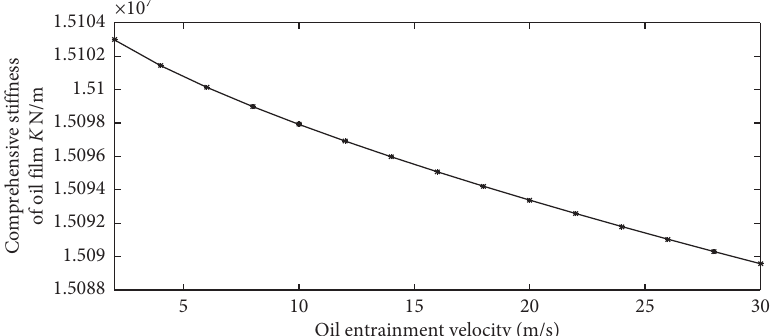
Figure 10: Comprehensive stiffness under different entrainment